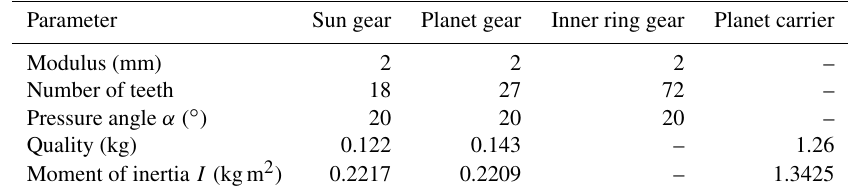
Table 1. Basic parameters of planetary system.